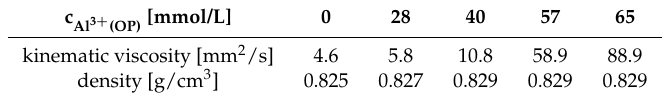
Table 5. Effect of concentration of aluminum ions on kinematic viscosity and density of organic phase.